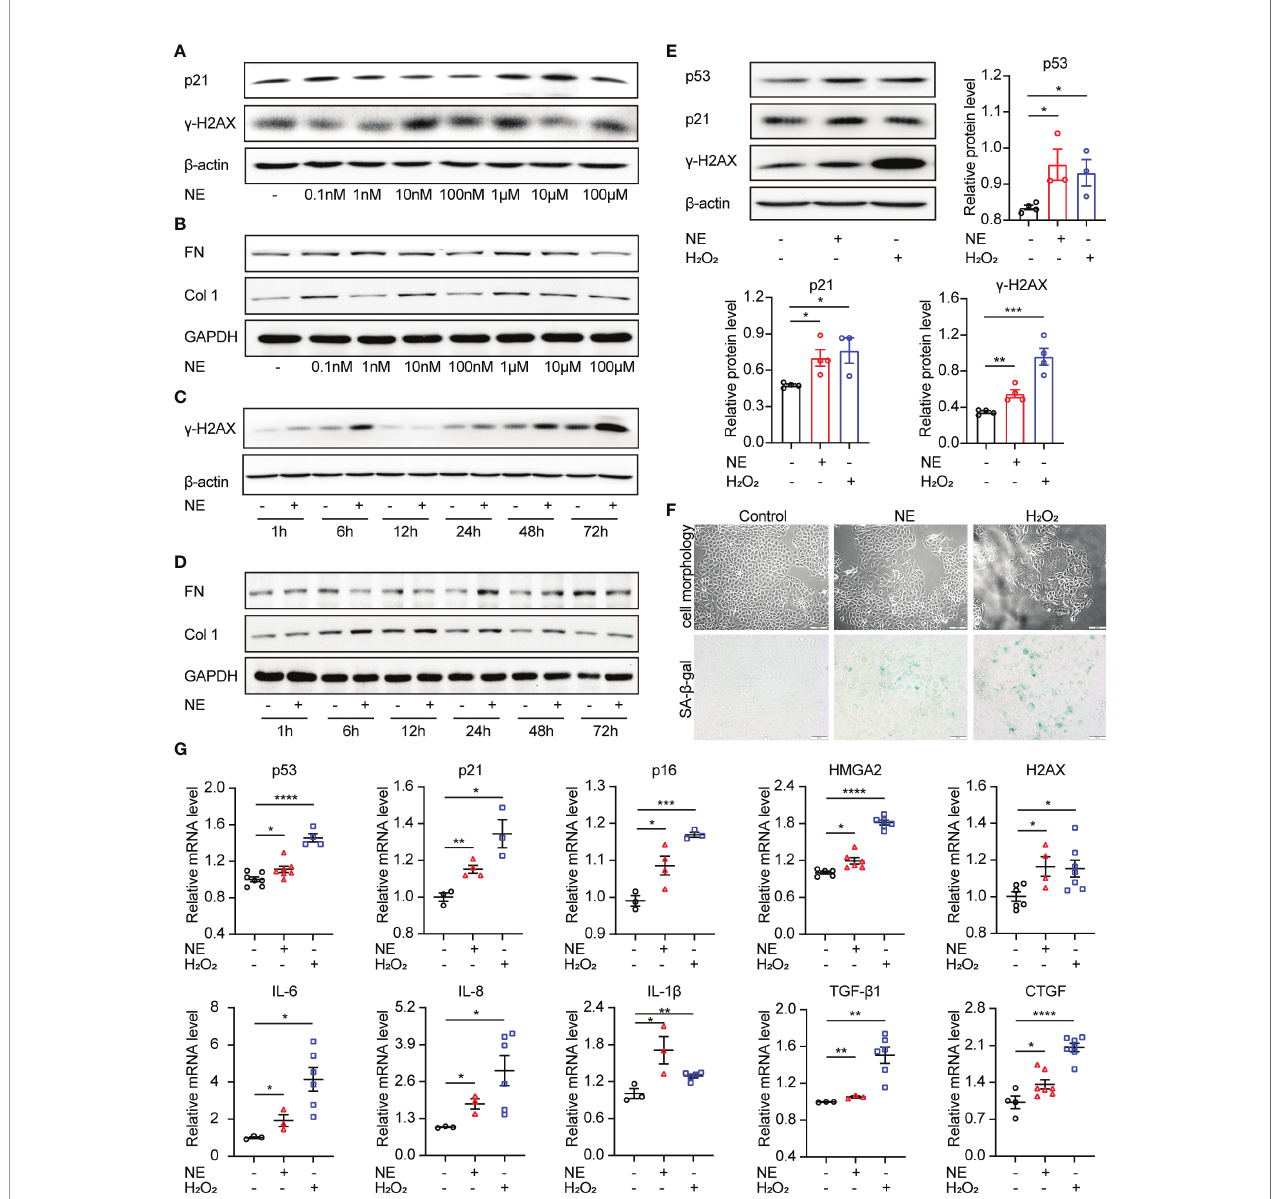
FIGURE 3 | Norepinephrine contributes to cellular senescence and upregulates pro fi brogenic and proin fl ammatory cytokines in renal tubular cells. (A, B) Representative Western blot of p21, g -H2AX or FN, Col 1 in TKPTS cells cultured with PBS (control) or different concentrations of NE (0.1 nM, 1 nM, 10 nM, 100 nM, 1 m M, 10 m M, and 100 m M) (n=3 in each group). (C, D) Representative Western blot of g -H2AX or FN, Col 1 in TKPTS cells incubated with PBS (control) or NE at a fi nal concentration of 10 nM for the indicated periods (1, 6, 12, 24, 48, and 72 hours) (n=3 in each group). (E – G) TKPTS cells were incubated with NE (10 nM) or H 2 O 2 (100 m M) for 48 hours and were then harvested. (E) Representative Western blot of p53, p21, and g -H2AX in TKPTS cells treated with PBS, NE, or H 2 O 2 with densitometry analysis (n=3 – 5 in each group). (F) Representative images of cell morphology and SA- b -gal staining of TKPTS cells treated with PBS, NE, or H 2 O 2 using a microscope (n=3 in each group). Scale bar=50 m m. (G) mRNA levels of senescence-related proteins (p53, p21, p16, HMGA2, H2AX), SASP components (IL-6, IL-8, IL-1 b ), and pro fi brotic cytokines (TGF- b 1, CTGF) in each group were detected by qRT-PCR analysis (n=3 – 7 in each group). *P < 0.05, **P < 0.01, ***P < 0.001, ****P < 0.0001. Bars represented means ±